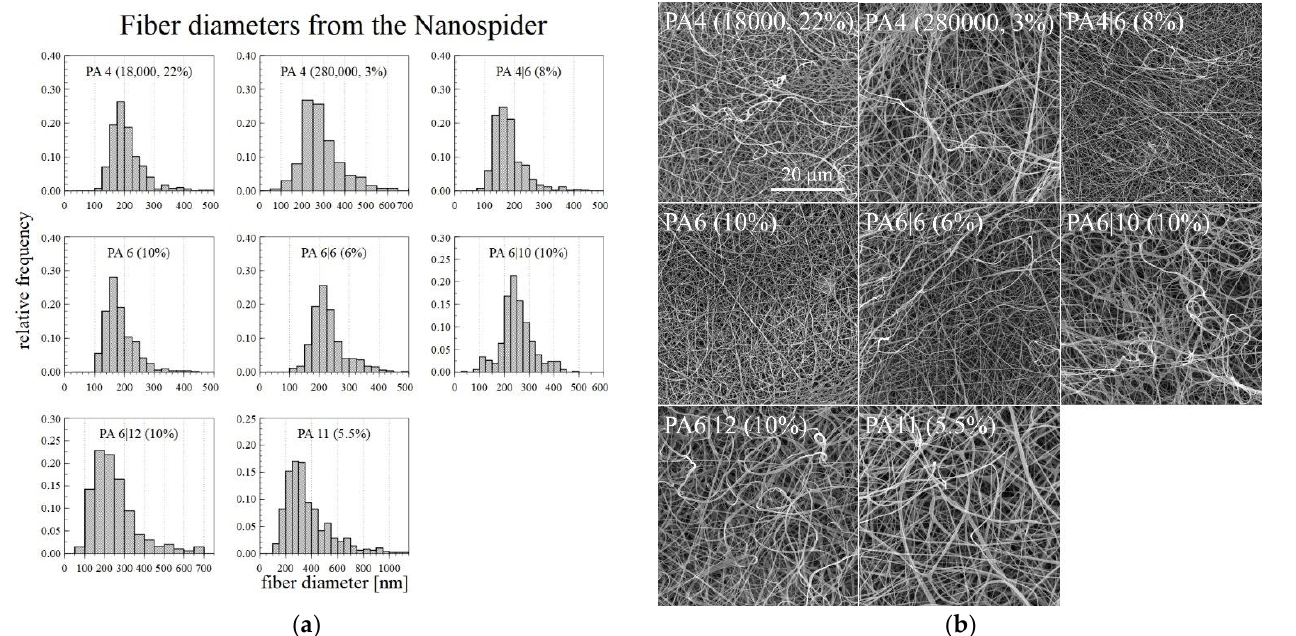
Figure 6. Histograms of the fiber diameters ( a ) and the corresponding SEM images ( b ) of the PA fiber layers prepared using the Nanospider TM machine.